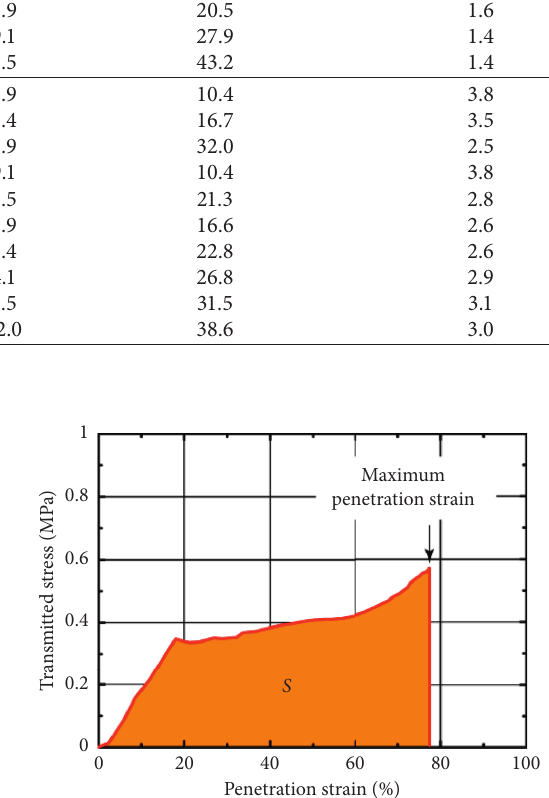
Figure 15: Integral values to the maximum penetration